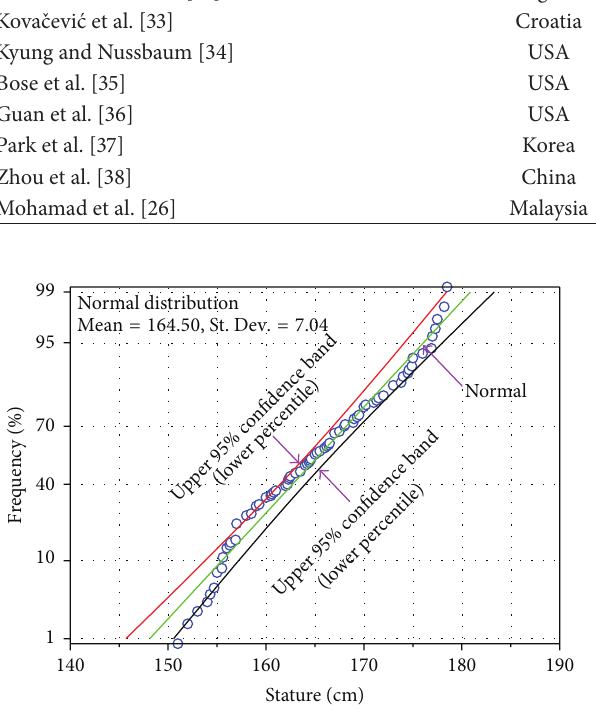
Figure 2: Distribution of stature of the